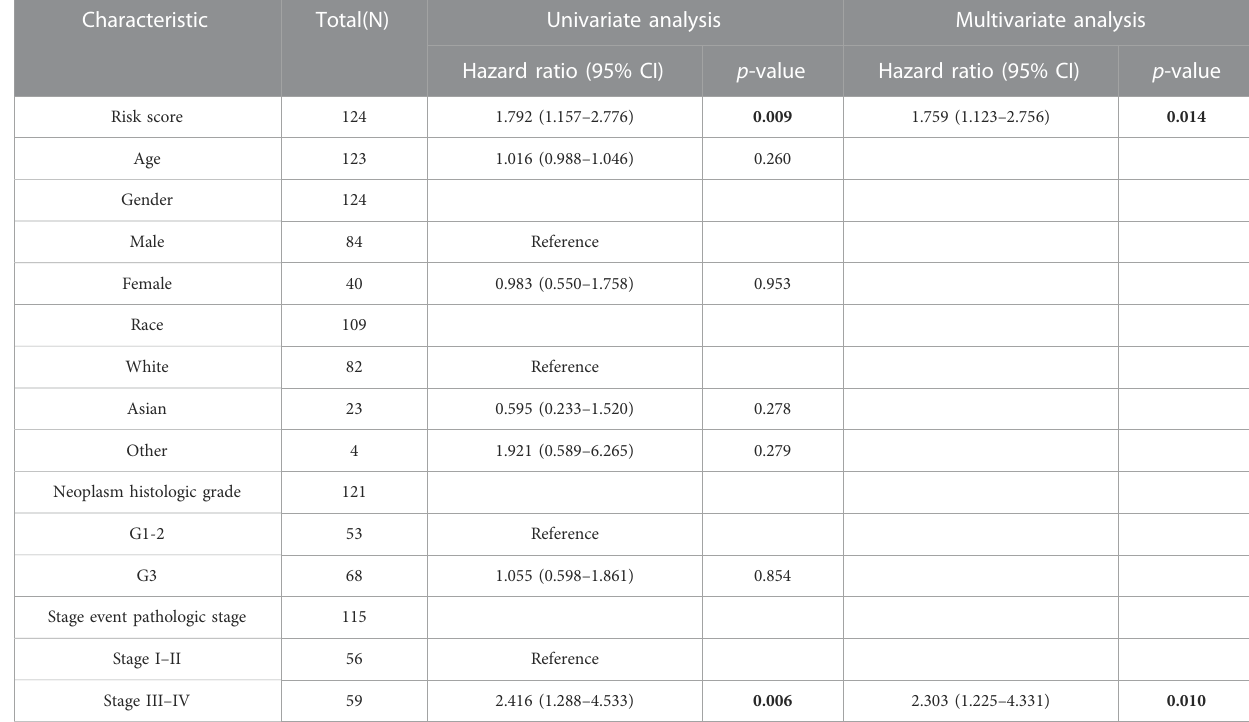
TABLE 3 Univariate and multivariate analyses of risk factors in the validation